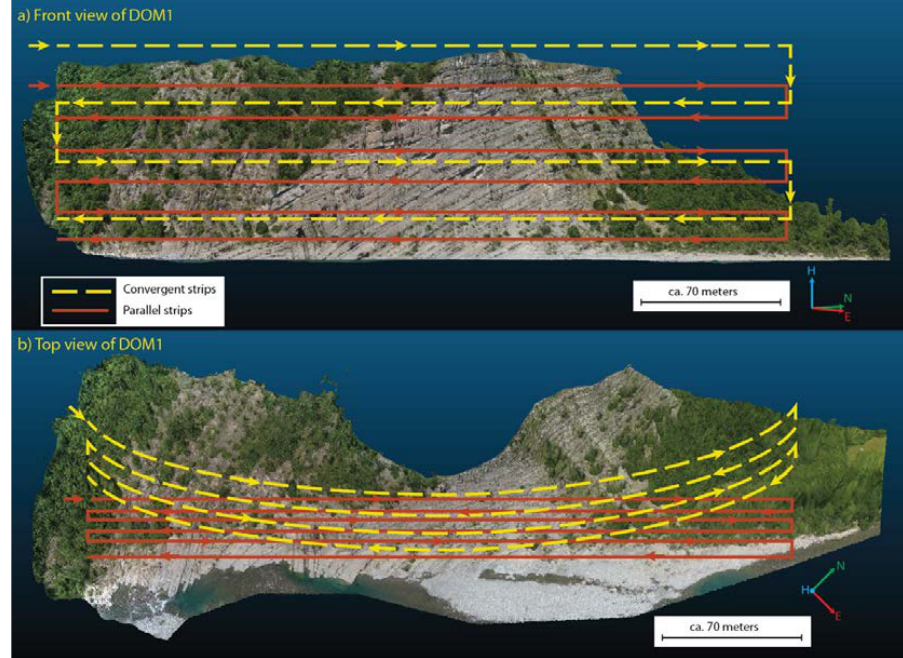
Figure 5. ( a ) Front and ( b ) top views of the flight plan showing flight lines and direction of flight used for the photogrammetric acquisition of DOM1. Pictures were acquired from positions parallel (red lines) and convergent (yellow lines) to the outcrop. The second UAV survey conducted with the same flight scheme.